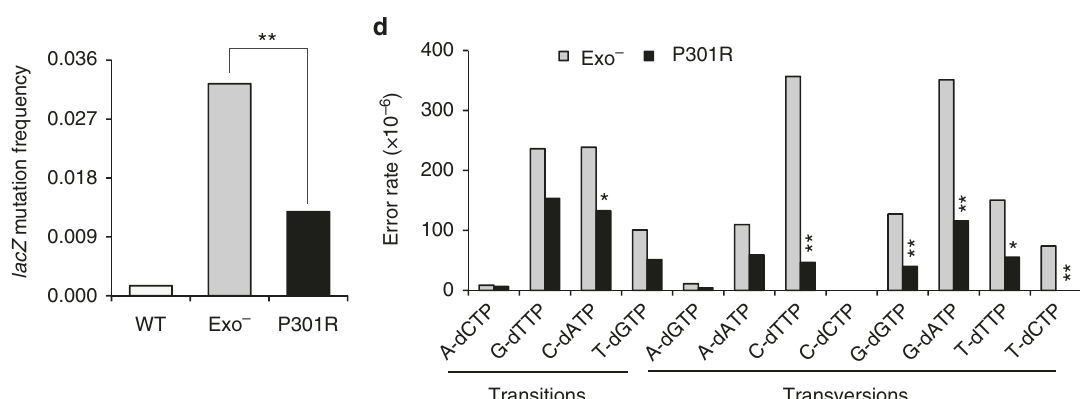
pol2-4 and pol2-P301R strains to the mutational speci fi city of the respective polymerases deduced from the in vitro fi delity assays.